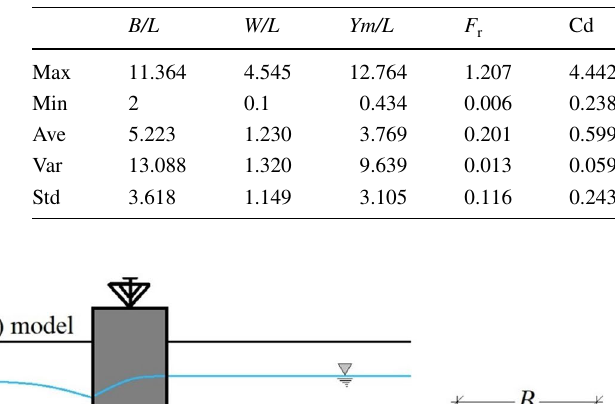
Table 1 Range of the dimensionless parameters reported by Ojha and Subbaiah (1997) and Hussain et al. (2011) for developing ORELM